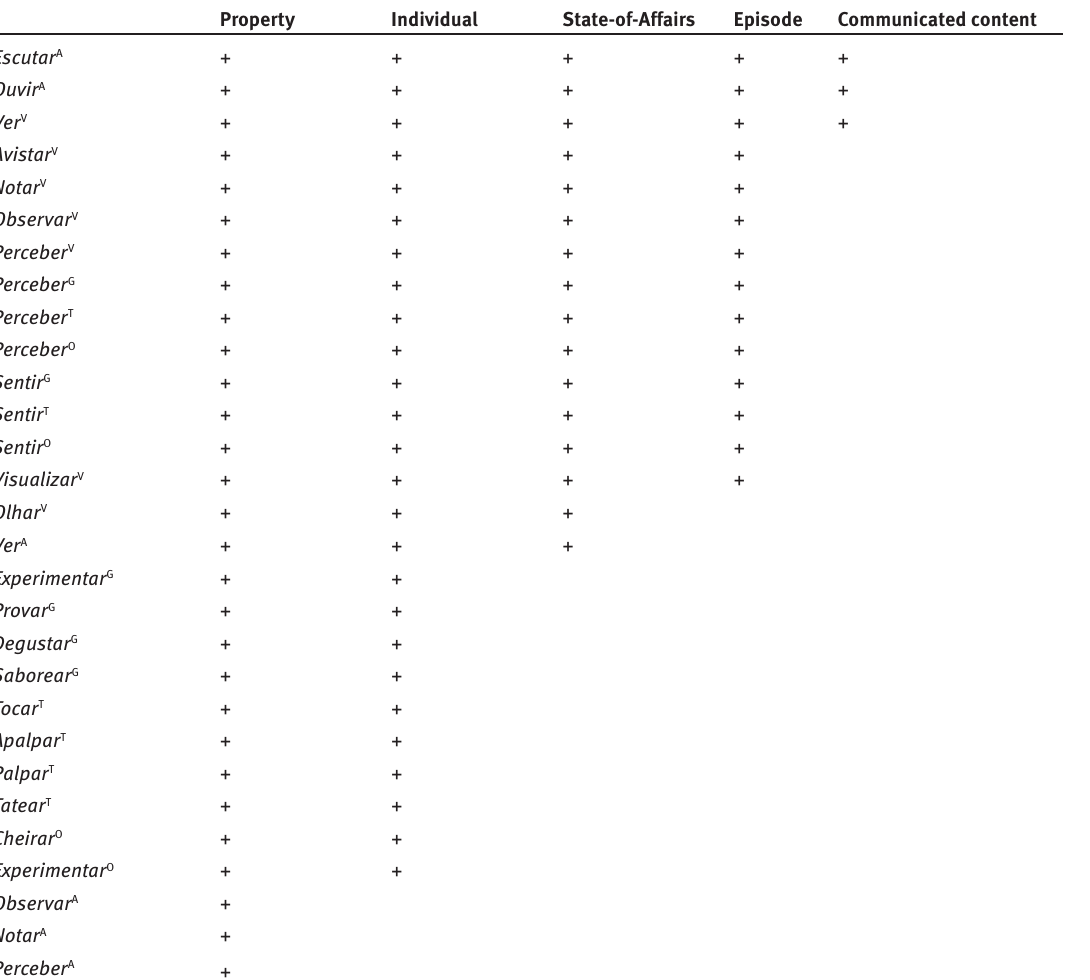
Table 3. The distribution of semantic complement